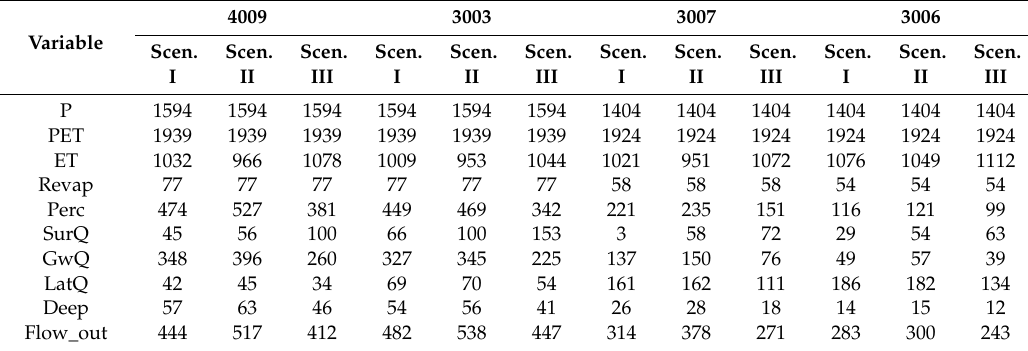
Table 8. Annual mean water balance variables of four Atibaia sub-basins according to SWAT, from 1990 to 2016 (in mm).